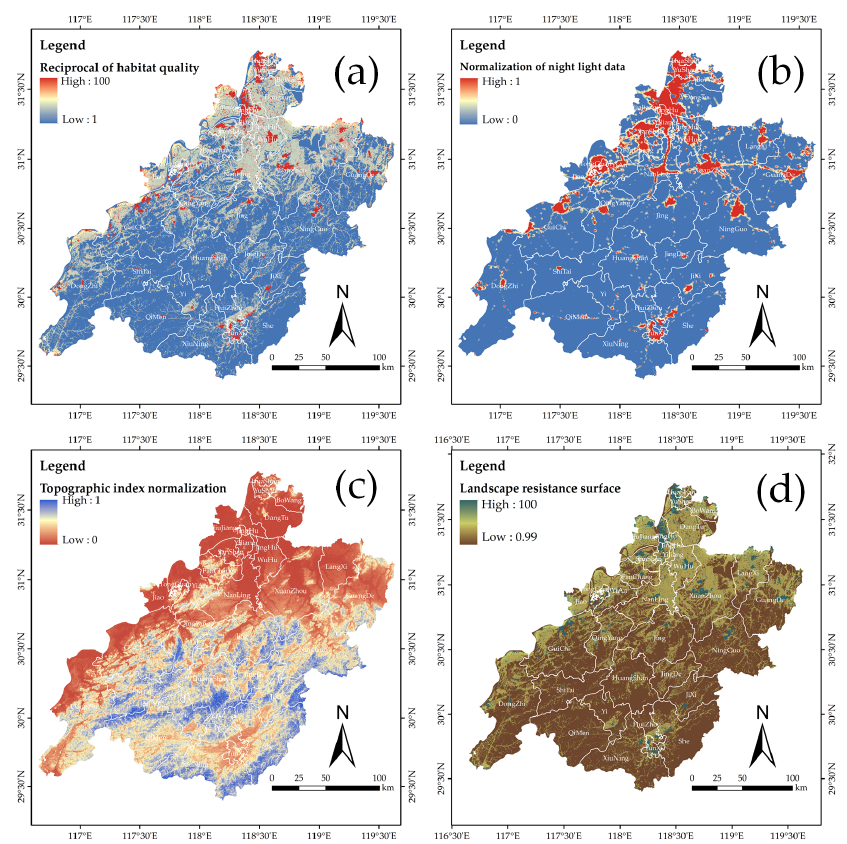
Figure 6. Ecological resistance surface in southern Anhui; ( a ) is the reciprocal of habitat quality; ( b ) is the night light index after standardization; ( c ) is the night light index after standardization; ( d ) is the landscape resistance surface.